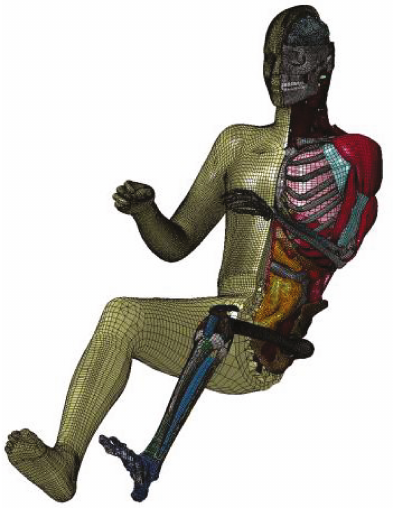
Figure 4: GHBMC model